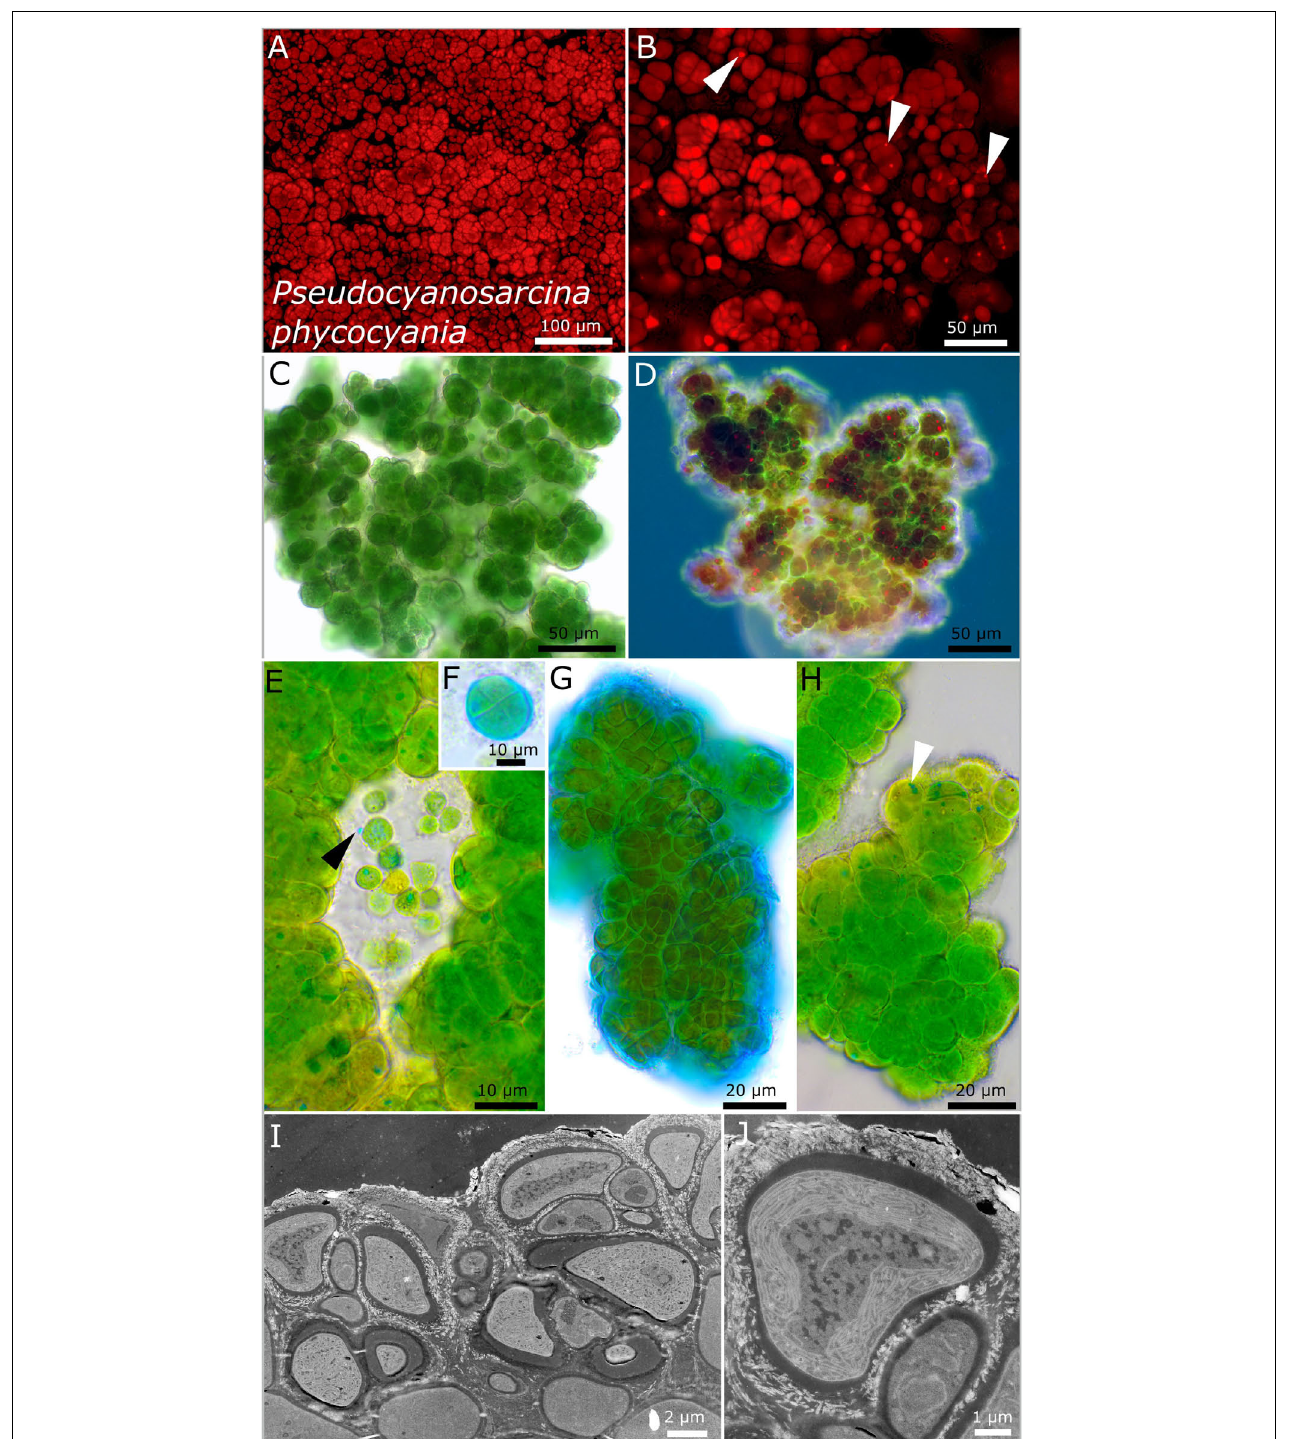
FIGURE 5 | Micrographs showing Pseudocyanosarcina phycocyania . (A,B) Fluorescence images showing phycocyanin granules [white arrows in (B) ]. (C–H) Light microscopy and (I,J) transmission electron microscopy (TEM) of lichen cross-sections. (C) Overview showing the rounded structure of the colonies. (D) Larger colony under simple polarized light with phycocyanin granules in red. (E) Close-up of released, unsheathed single cells with blue phycocyanin granules that can be excreted outside of the cells (black arrow). (F,G) ACN staining showing a round tetrad of four cells and the firm, non-lamellate, limited sheath. (H) Colony made of dense cells, tightly pressed against each other and forming rounded packages comprising a few cells with blue phycocyanin granules (white arrow). (I,J) TEM images showing the cell of the photobiont arranged in the lichen thallus and the lamellar, parietal position of the thylakoid membranes within the cells.